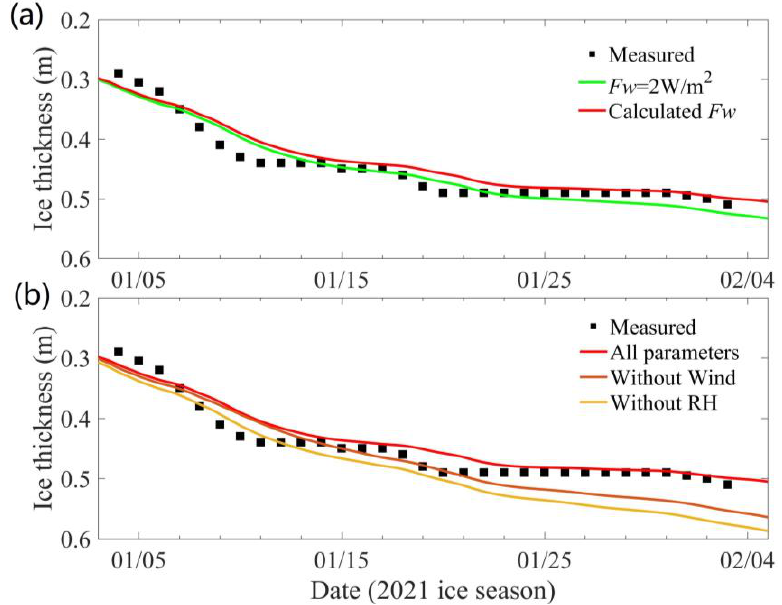
Figure 11. ( a ) Simulation results under different oceanic heat fluxes (4 January – 4 February in 2021 ice season); ( b ) sensitivity analysis of wind and relative humidity.